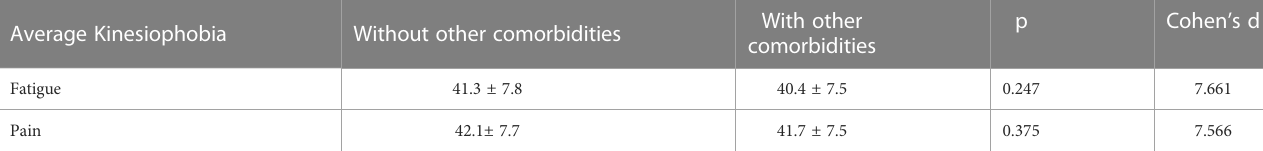
Average Kinesiophobia